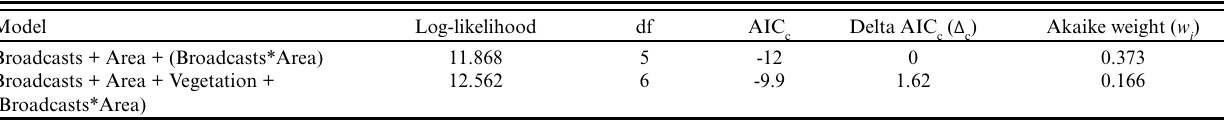
Table 3 . Top ranked logistic regression models (< 2 Δ AIC traillii ) were detected.